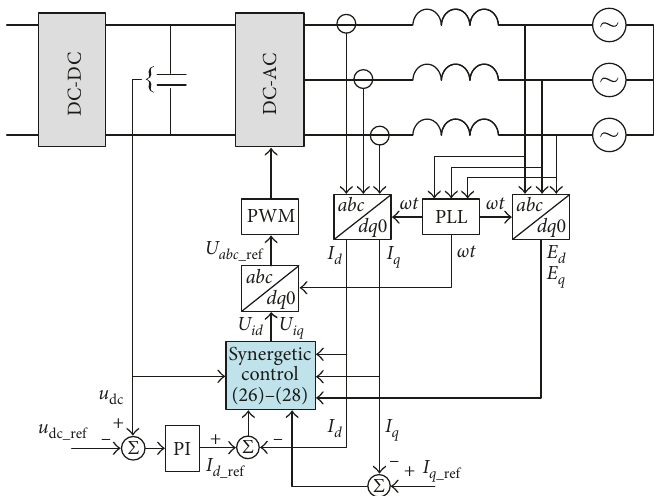
Figure 3: Synergetic control scheme of the PV system in normal